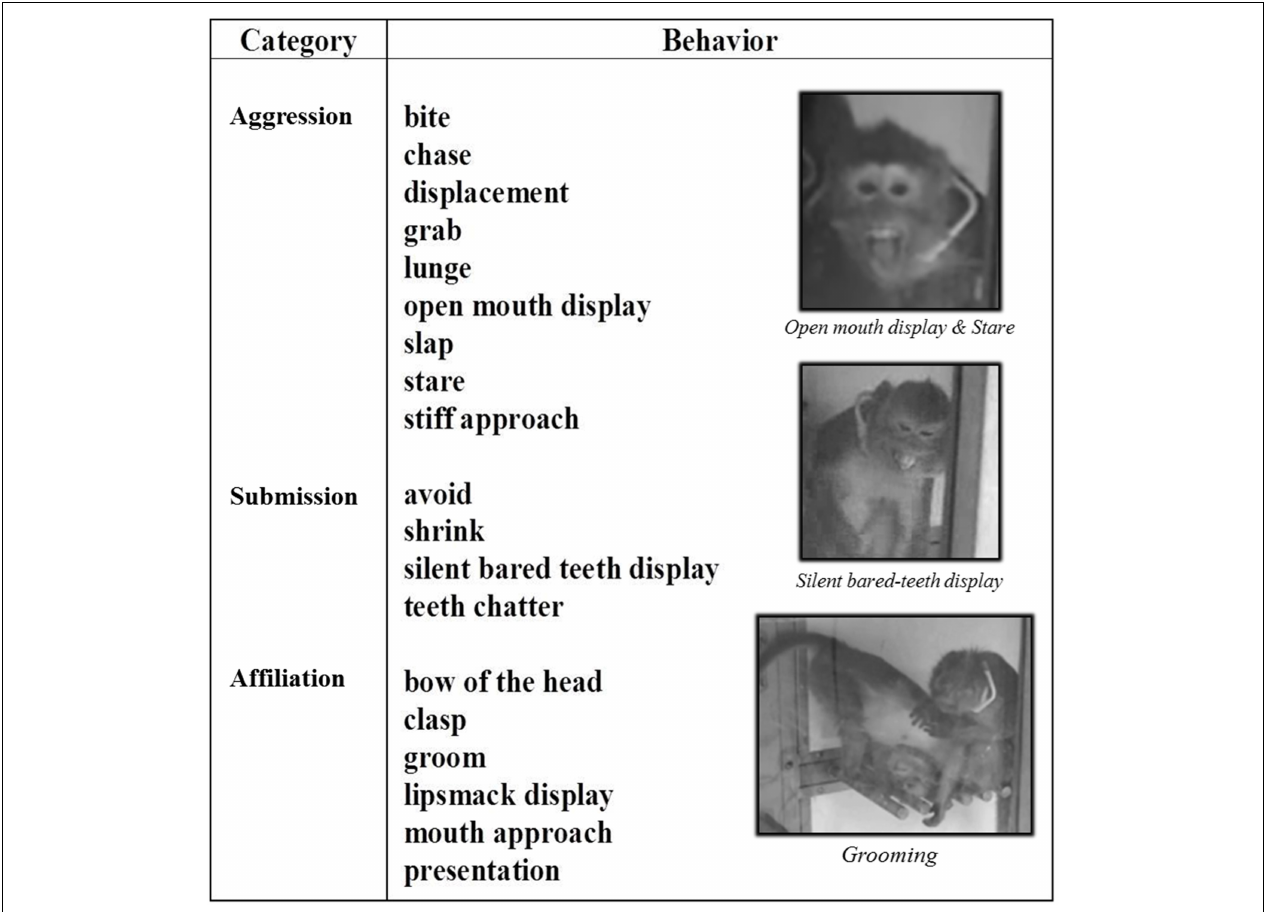
FIGURE 2 | Social behaviors of long-tailed macaques. Social behaviors of long-tailed macaques are split into three categories: Aggression, Submission and Affiliation. In this study, 19 social behaviors were assessed, some of which